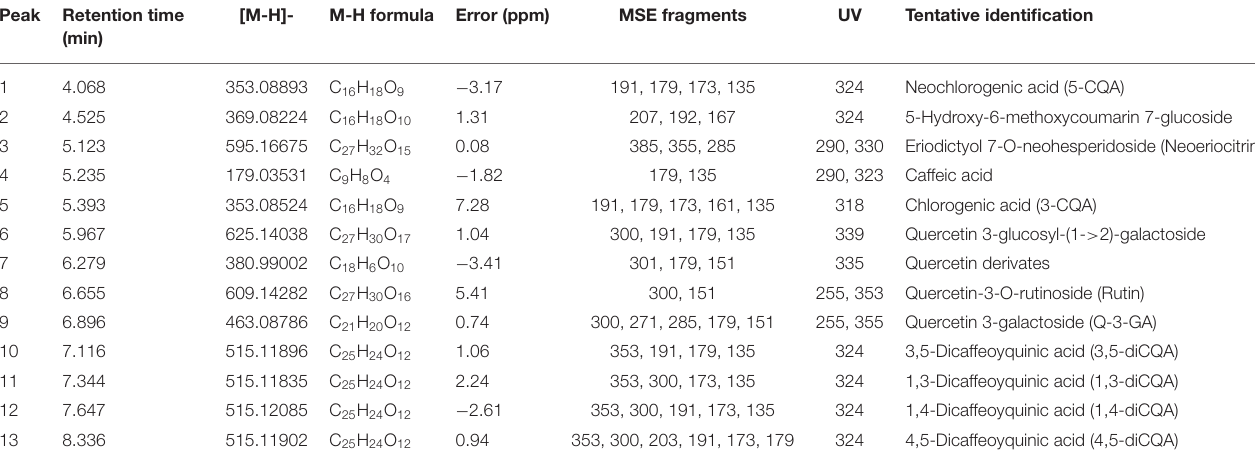
TABLE 1 | Tentative identification of phenolic compounds in the leaves of different sweet potato cultivars by UPLC–QTOF/MS. Peak Retention time